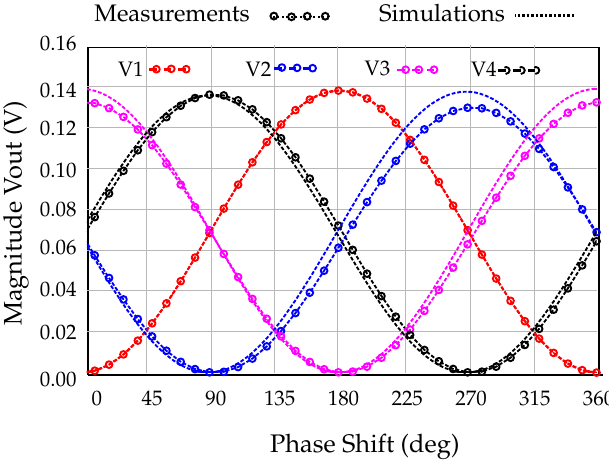
Figure 7. Magnitude of the power detected voltages at 77GHz.